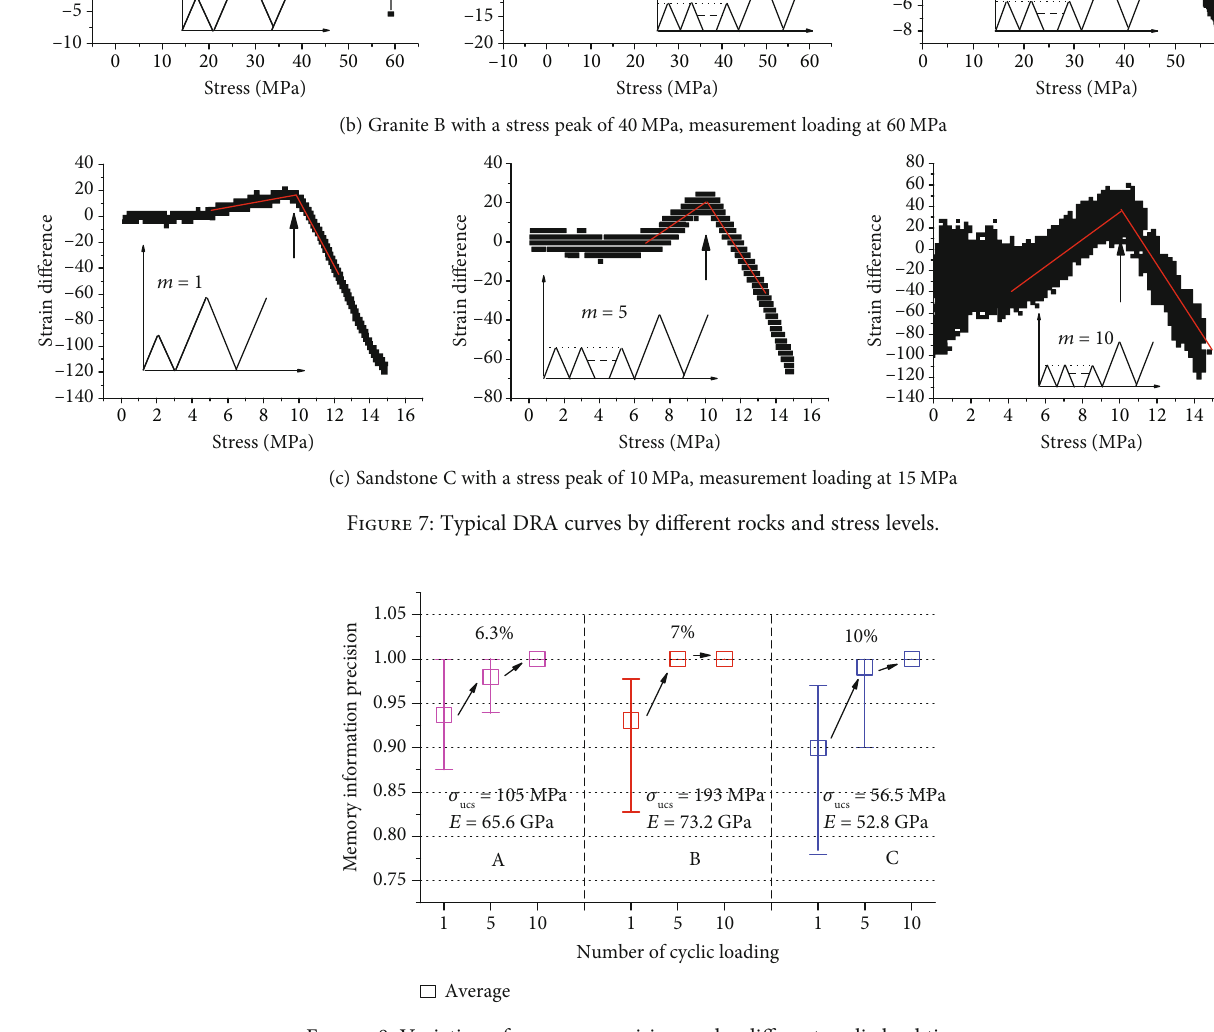
Figure 8: Variation of memory precision under di ff erent cyclic load